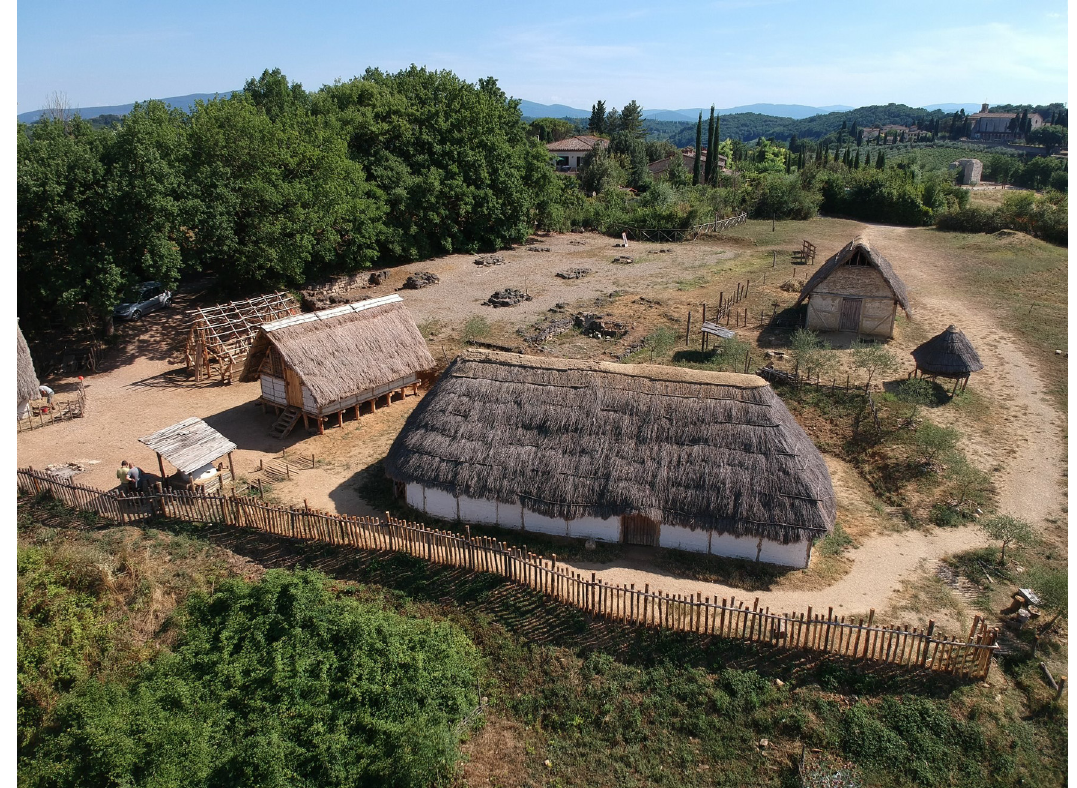
Figure 1: The open - air museum of